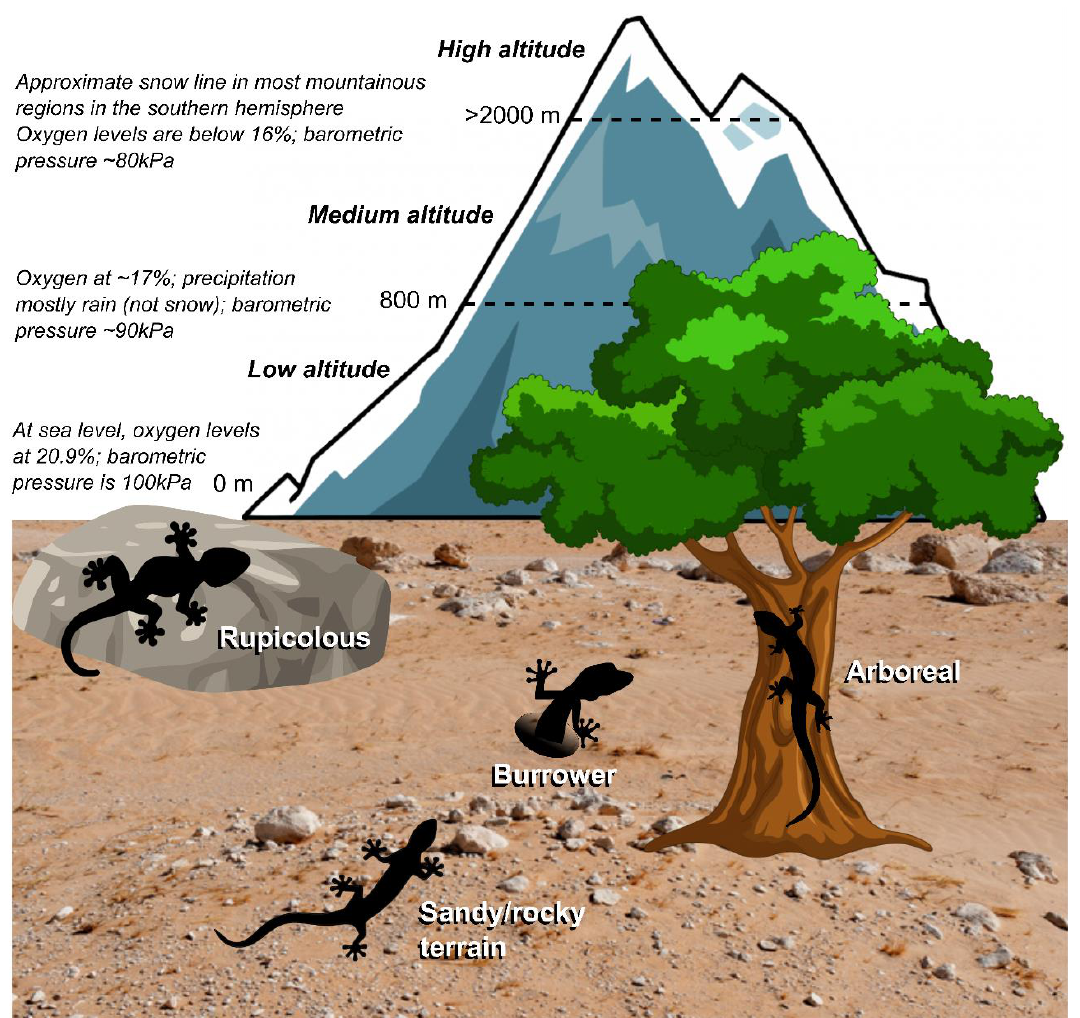
Figure 1. Representations of gekkonid genera within South Africa: ( A ) Simplified phylogenetic represen- tation of the genera, constructed from the phylogeny produced in this study and from various published gekkonid phylogenies [15,37–41]. Numbers at the nodes indicate the Clade number (as in Figure S1). Pie charts at the tips indicate the number of species within the genus that inhabit various altitudes (green pie charts), the general habitat in which the species are found (biotopical preferences, blue pie charts), and the habitat specialisation of the species (orange pie charts). Genera that are underlined have species that enter in Red List (https://www.iucnredlist.org/; accessed on 17 December 2022). ( B ) Donut chart to the urban environment. Information for the pie charts was obtained from the species accounts in the IUCNshowing the number of species from each genus present in South Africa, Lesotho, and Eswatini. The illustration below details the biotopical preferences and altitudinal zone